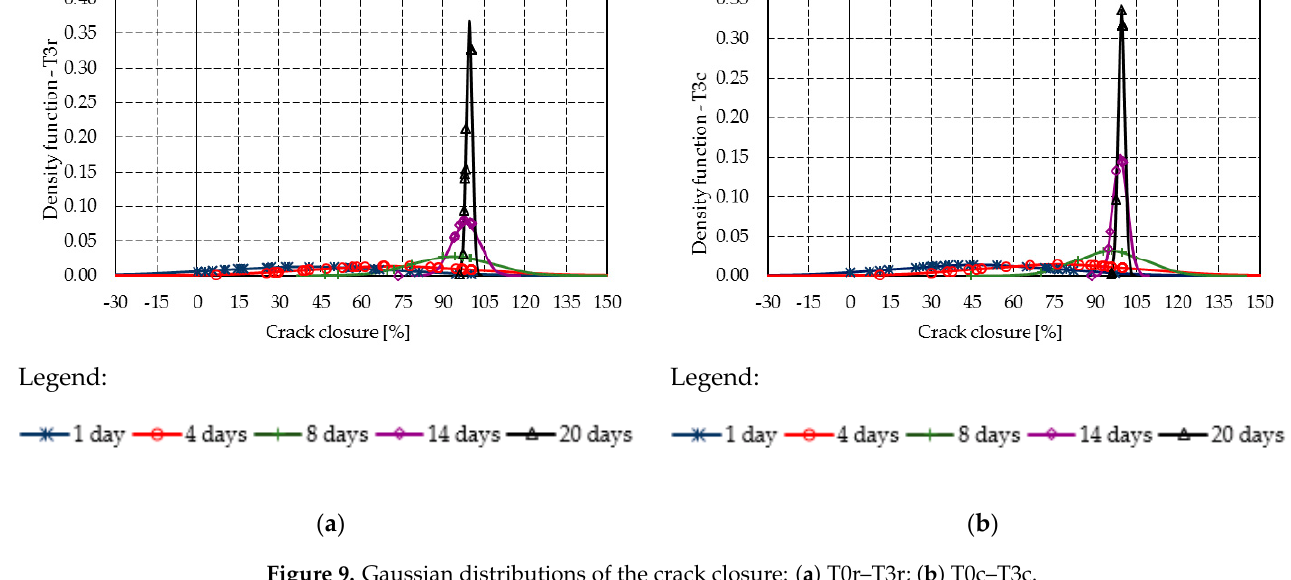
Figure 9. Gaussian distributions of the crack closure: ( a ) T0r–T3r; ( b ) T0c–T3c. Table 5. Probabilistic parameters and probabilities of crack closure at 20 days. µ / Mixture